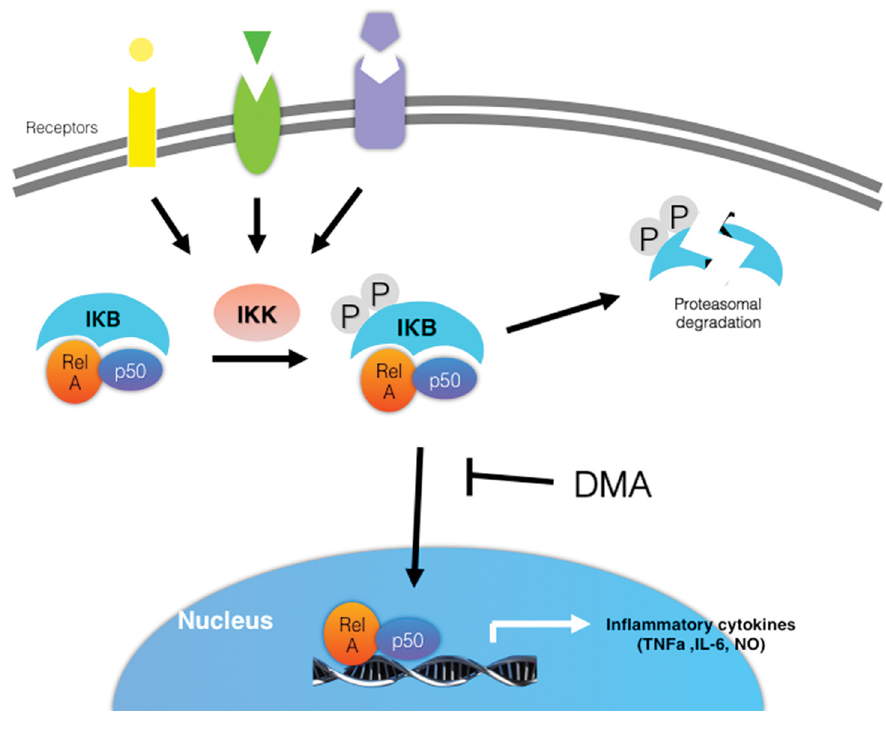
Figure 7. DMA prevents p50/Rel driven transcription of inflammatory cytokine genes by inhibiting I κ B